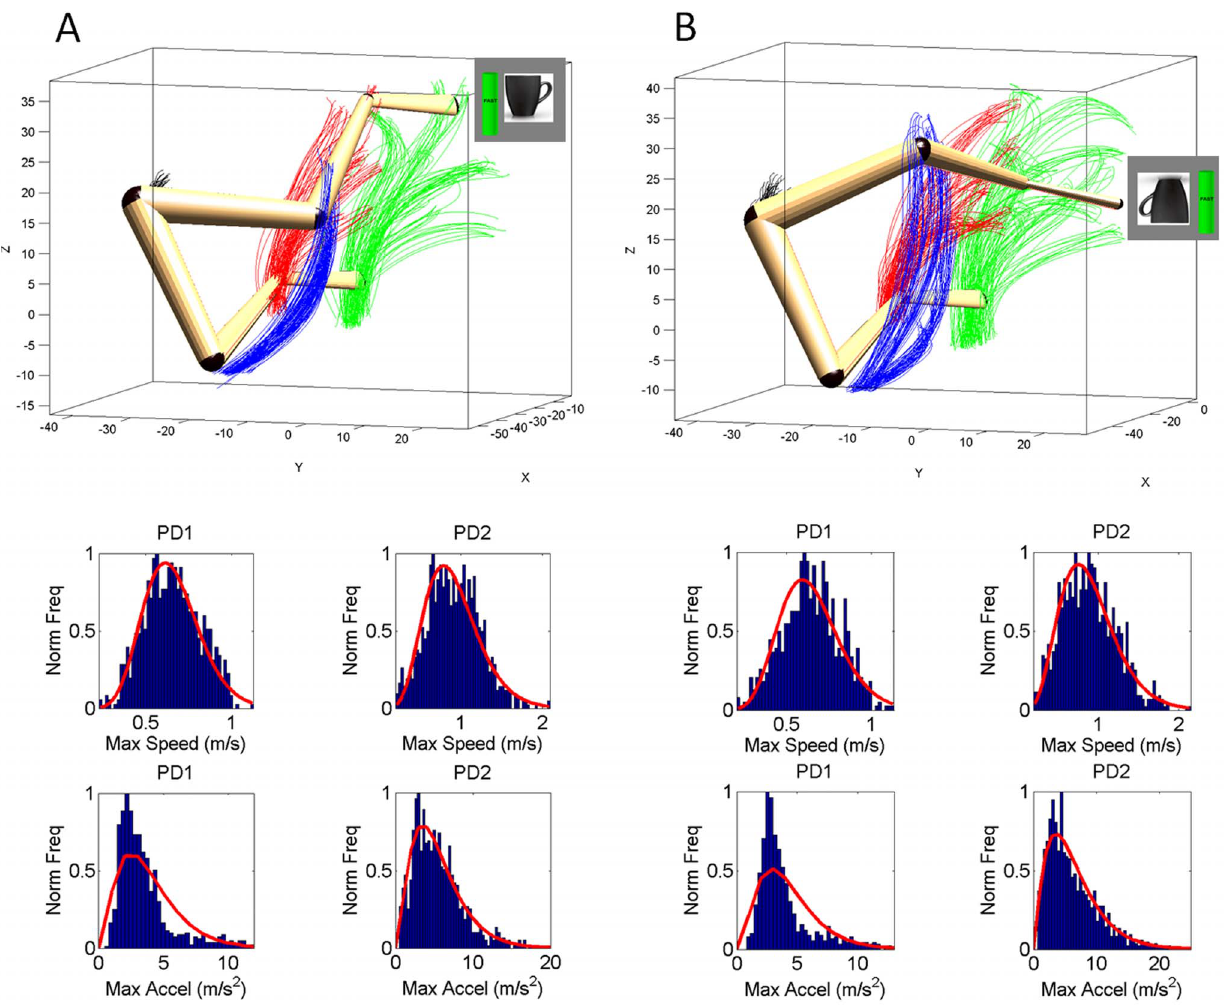
Figure 10. Normalized frequency distribution of the maximum speed and maximum acceleration values from the retracting primed motions in two groups of patients with PD. (A) Arm trajectories (shoulder, elbow, wrist, and hand) during the primed-UP condition similar to the DEFAULT case. The initial and final arm postures corresponding to the trajectories towards two randomly selected positions are superimposed. Patients in the PD1 group had a nearly symmetric distribution of speed maxima in the primed-UP condition where their retracting motions could no longer differentiate between the randomly instructed speeds. The group of PD2 was comprised of patients whose retracting motions could, on average, differentiate between instructed fast or slow speeds during the easier primed-UP cases. Their distribution of maximum speed values was skewed.